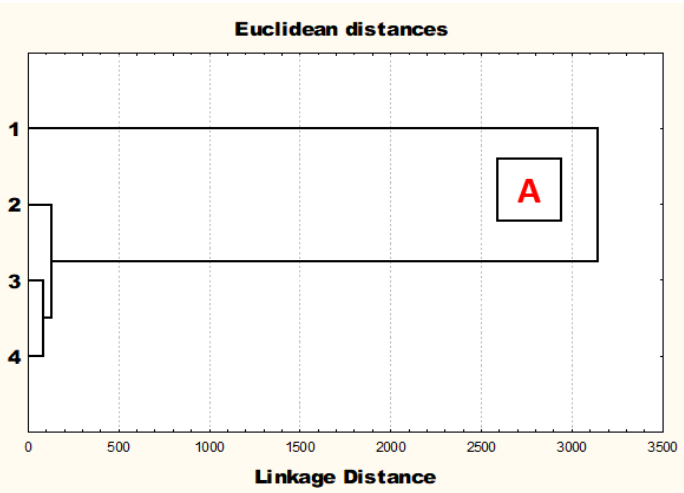
Figure 8. Cluster analysis of radon × oncological maladies interaction; 1 — radon concentration, 2 — incidence of bronchopulmonary cancer, 3 — incidence of hemoblastoses and 4 — incidence of thyroid gland cancer. The most important cluster, labeled as A, shows a significant linkage between radon and bronchopulmonary cancer.